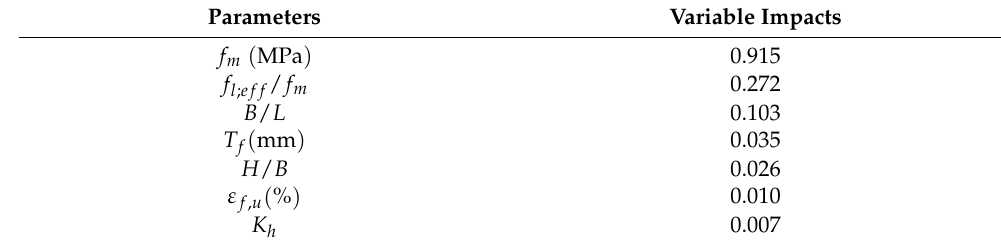
Table 3. Parameters and their impacts in complex symbolic regression